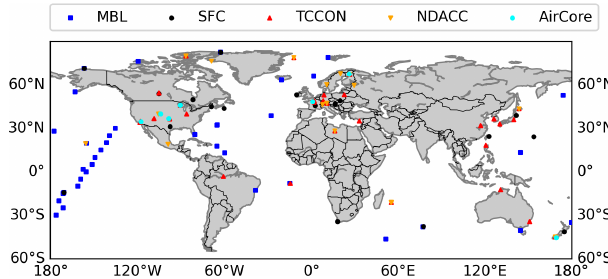
Figure 7. Map with observation sites used in the evaluation of the CAMS GHG reanalysis: the marine boundary layer (MBL, blue squares) includes NOAA MBL reference sites used to com- pute the NOAA global mean CO 2 and CH 4 mole fraction product (see https://gml.noaa.gov/ccgg/mbl/mbl.html, last access: 18 March 2023, for further details), SFC (black circles) corresponds to the in situ near-surface continuous observations of CO 2 and CH 4 , TC- CON and NDACC sites are depicted by red and orange triangles, and AirCore sites are shown by cyan